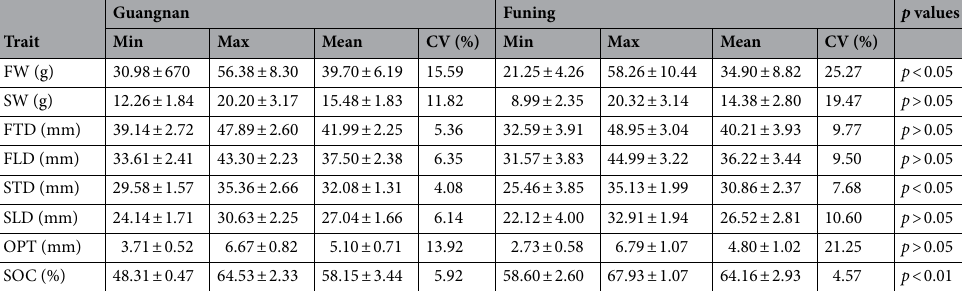
Table 2. Fruit characteristics of Malania oleifera individuals in Guangnan and Funing (mean ± SD). FW mean fruit weight, SW mean stone weight, FTD mean fruit transverse diameter, FLD mean fruit longitudinal diameter, STD mean stone transverse diameter, SLD mean stone longitudinal diameter, OPT outer pericarp thickness, SOC seed oil content, Max maximum value in individual trees, Min minimum value in individual trees, Mean mean value among individual trees at one site. p values indicate significantly different level between Guangnan and